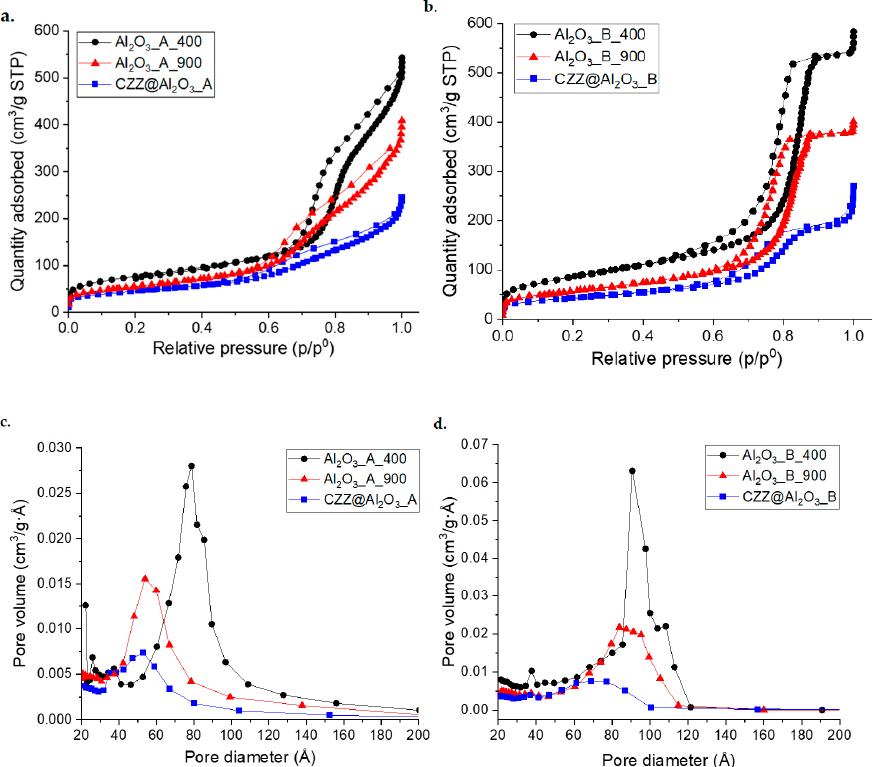
Figure 2. Nitrogen physisorption isotherms ( a , b ) and BJH pore size distribution ( c , d ) for the two series of samples Al 2 O 3 _A (from P123) and Al 2 O 3 _B (from F127).